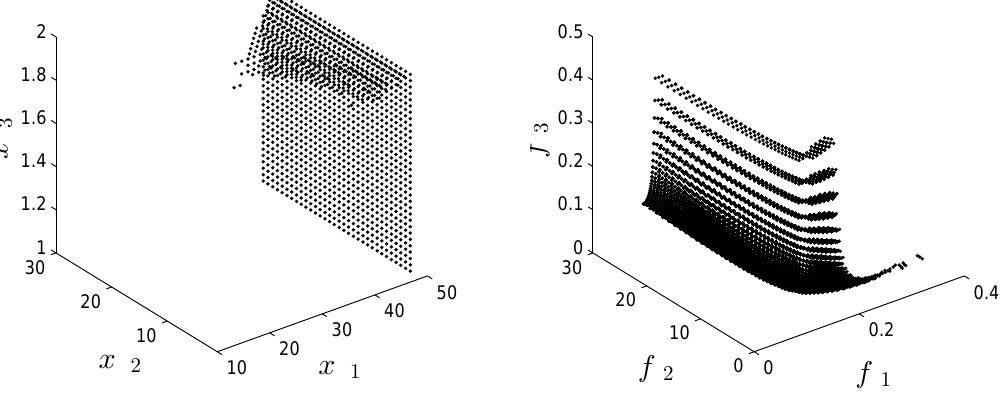
Figure 6. Approximation of the lightly robust optimal solutions and their worst-case image found by